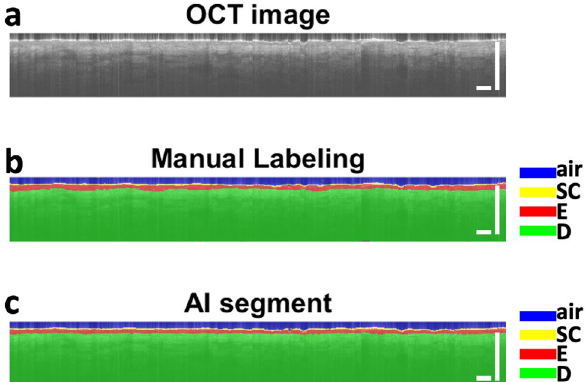
Figure 2. ( a ) OCT image and ( b ) manually labeled layers of air (blue), stratum corneum (SC) (yellow), epidermis (red), and dermis (green) for U-Net training; ( c ) U-net generates labels for individual pixels of the OCT image. Scale bars represent 1